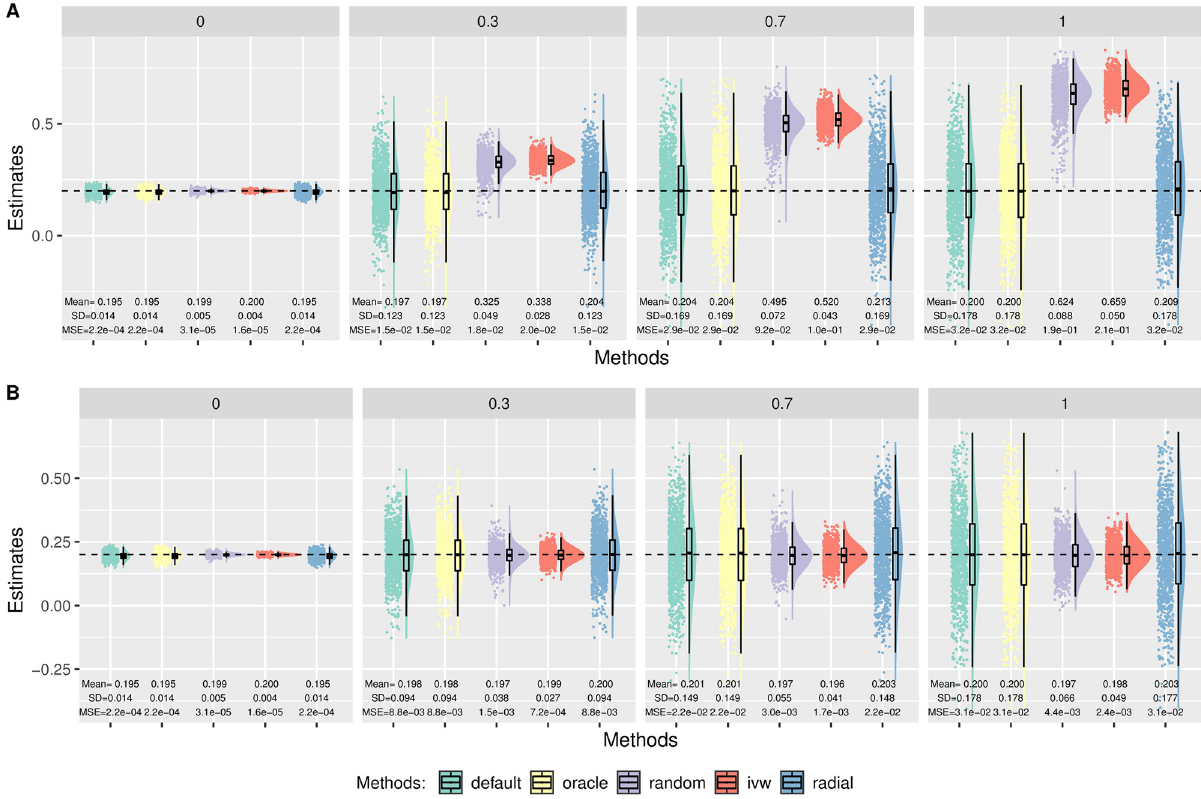
Fig 6. Simulation (c) results with n = 100 000, θ = 0.2, m = 100. Empirical distributions of the estimates of the causal effect θ by the methods. Each column corresponds to 0%, 30%, 70% or 100% invalid IVs. A: Directional pleiotropy. B: Balanced